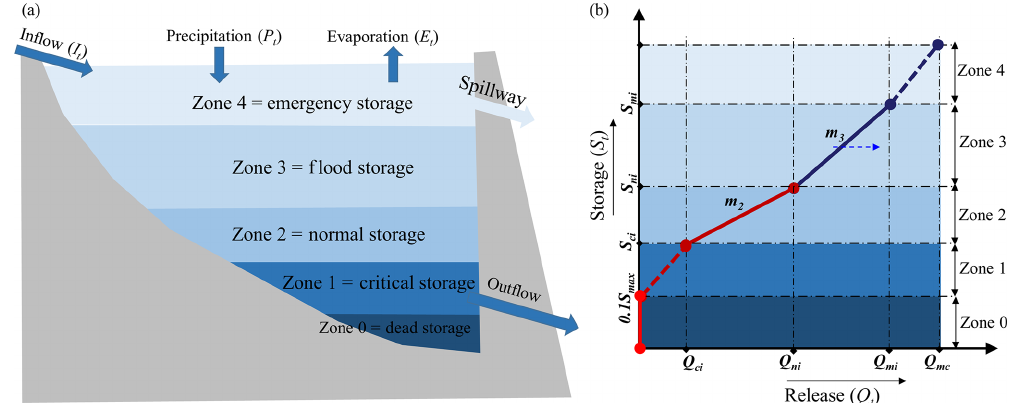
Figure 1. The schematic representation of reservoir zoning and the storage-release function: (a) four (active) reservoir zones with inflows and outflows, and (b) piecewise-linear reservoir-release function. m 1 and m 2 control the slope of the release curve, and they change monthly. The upward blue arrow is to indicate that inflow to the reservoir may also be considered in determining the release in Zone